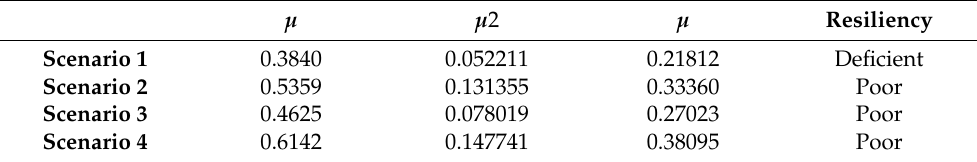
Table 17. Resiliency